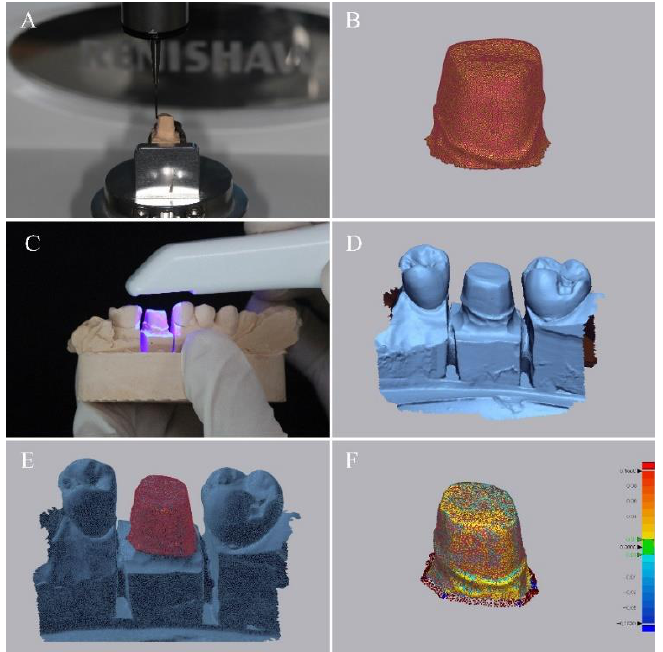
Figure 2. Procedure for evaluating 3D analysis. ( A ) Contact scanning procedure for CAD reference model (CRM). ( B ) CRM. ( C ) Scanning procedure for CAD test model (CTM). ( D ) CTM. ( E ) Superimposition of CRM and CTM. ( F ) 3D evaluation.